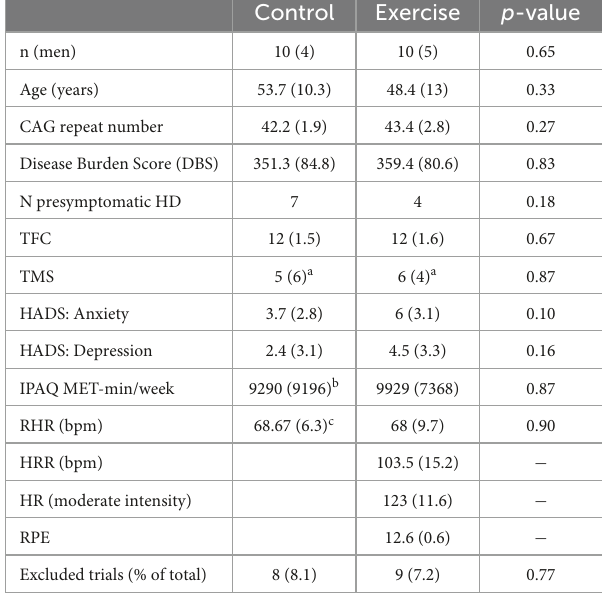
of these criteria and graphical examples, see the Supplementary material ). The mean percentage of excluded trials per participant